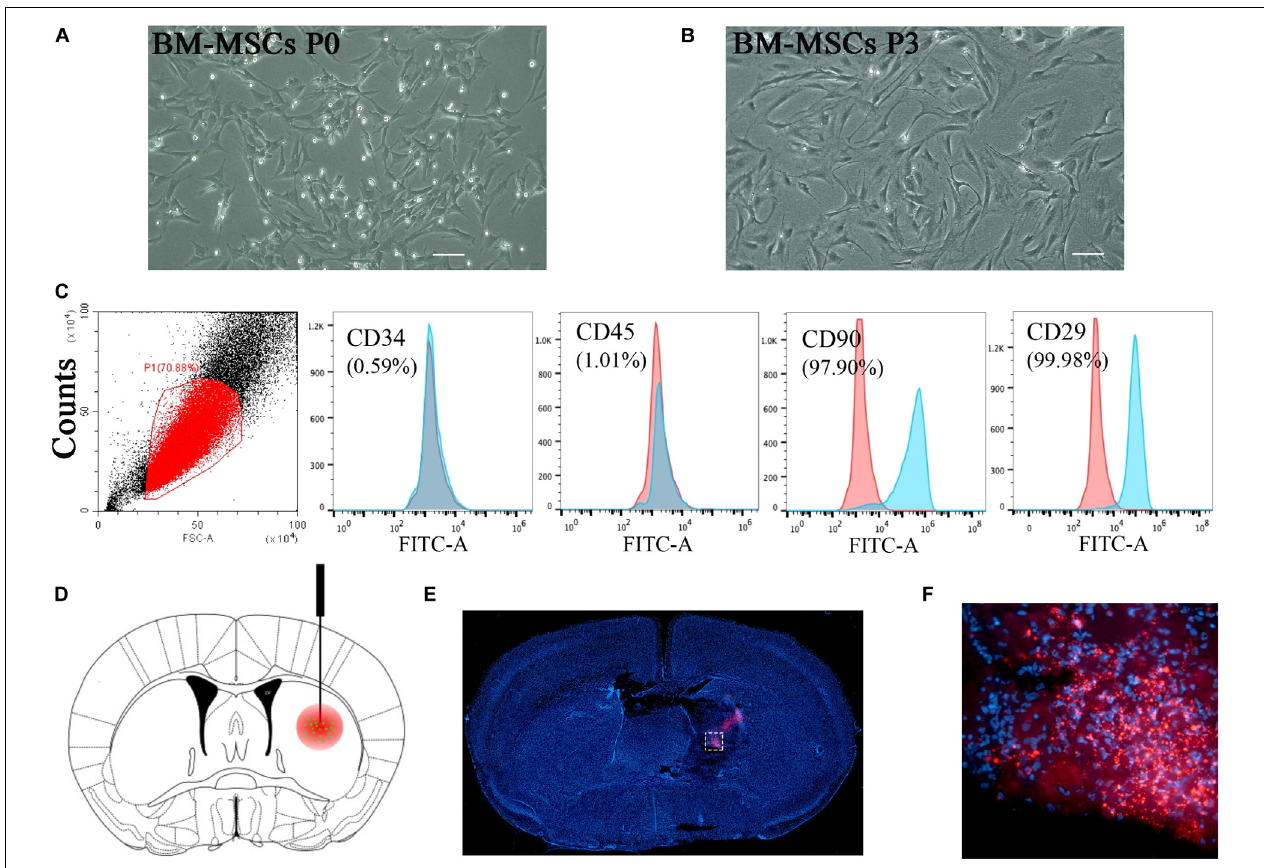
FIGURE 1 | BM-MSCs isolation, identification, and transplantation. (A,B) Morphology of MSCs in cell culture. Cultured cells (passage 0 and passage 3) showed typically spindle-shaped morphology under phase-contrast microscopy. Bar = 50 µ m. (C) Flow cytometry analysis of BM-MSCs at passage 3 depicted that cultured cells were negative for CD34 and CD45, and positive for CD90 and CD29. (D) Schematic diagram of BM-MSCs (green) stereotactically injected into the lesion area (red). (E) Red fluorescent (PKH26 dye) cells were located in the lesion area after 3 days of injection. Bar = 100 µ m. (F) Magnification pictures of the injured